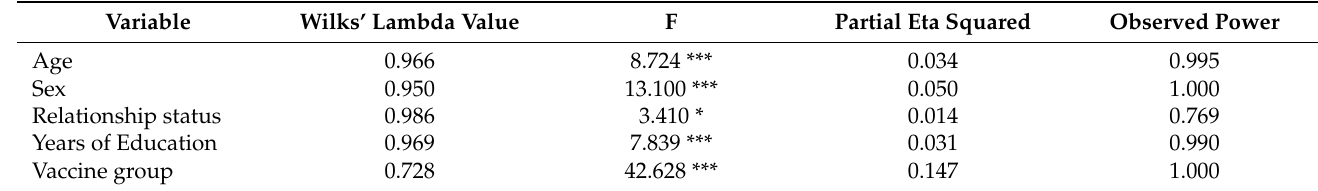
Table 3. Multivariate tests of the study variable by vaccine group.